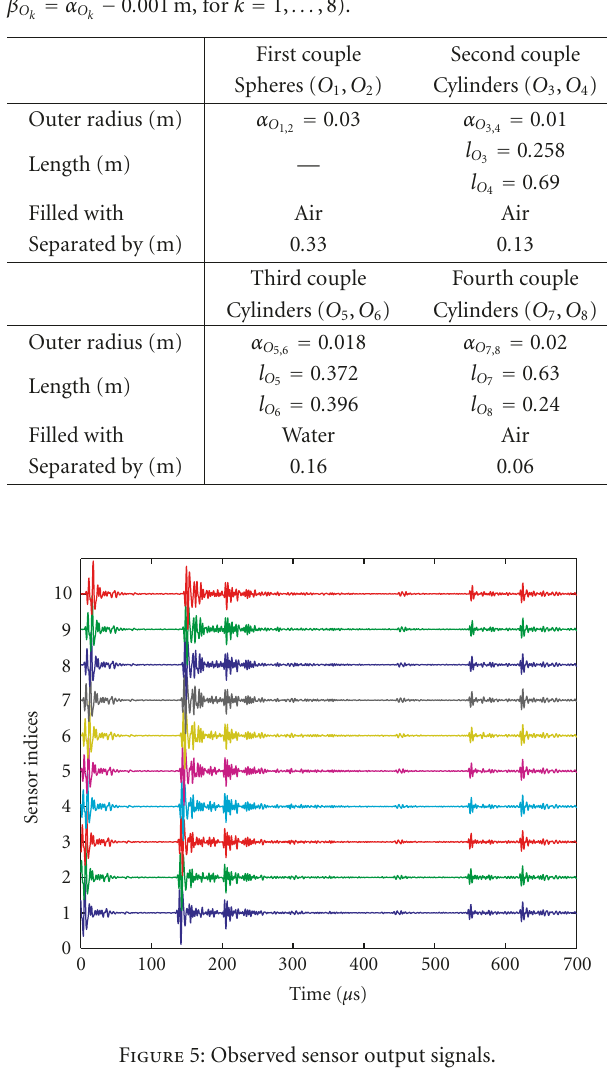
Table 1: Characteristics of the various objects (the inner radius β